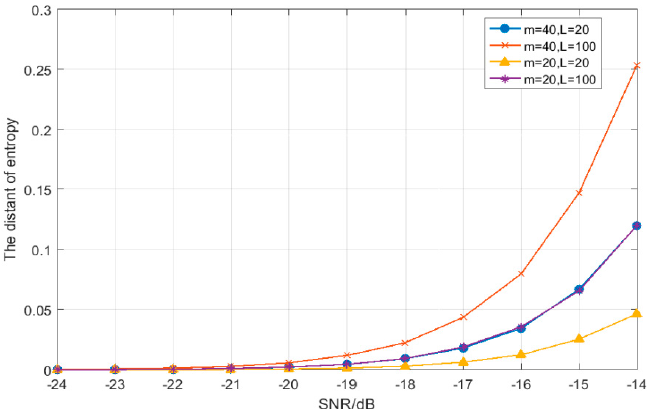
Figure 9. The relationship between SNR and the sum of the squares of the distance of adjacent singular